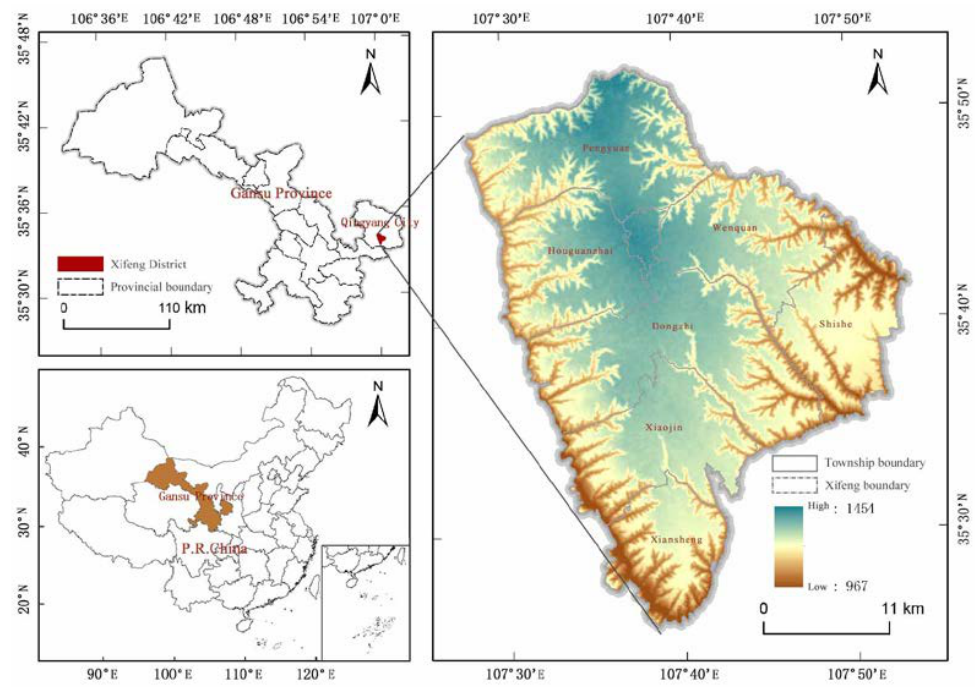
Figure 1. Study Figure 1. Study area.